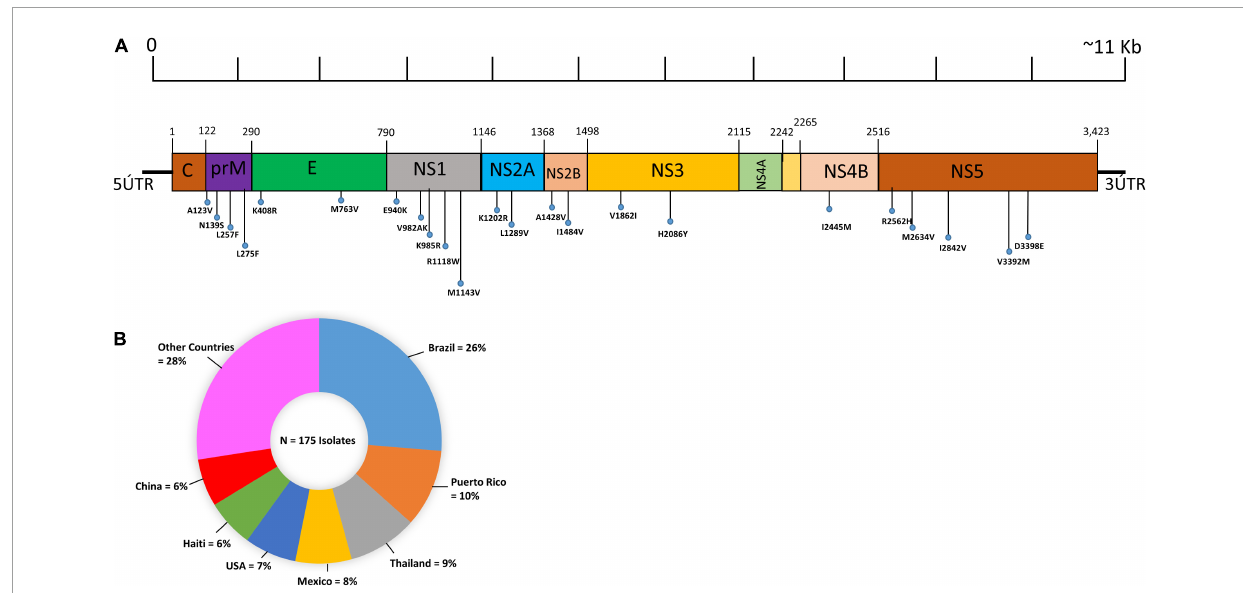
FIGURE1 Pictorial representation and geographic distribution of ZIKV genome sequences. (A) Pictorial representation illustrating the distribution of recurrent mutations and hypervariable genomic hot spot mutations in structural (C, preM, E) and non-structural proteins (NS1, NS2A, NS2B, NS3, NS4A, NS4B, and NS5) along with the ZIKV genome. The genomic hotspots are represented by vertical lines. (B) Geographic distribution of the 175 complete genome sequences of ZIKV. The pie chart represents the percentage of genomes of the ZIKV genomes sequenced according to their geographic origins. The colors indicate different